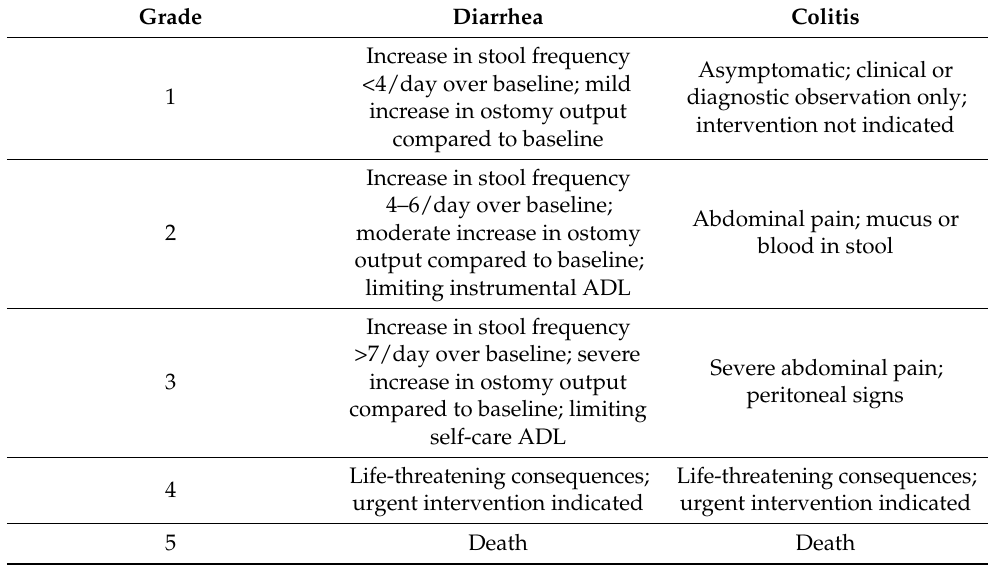
Table 1. Common Terminology Criteria for Adverse Events (CTCAE) for diarrhea and colitis (vers. 5.0). ADL: activity of daily